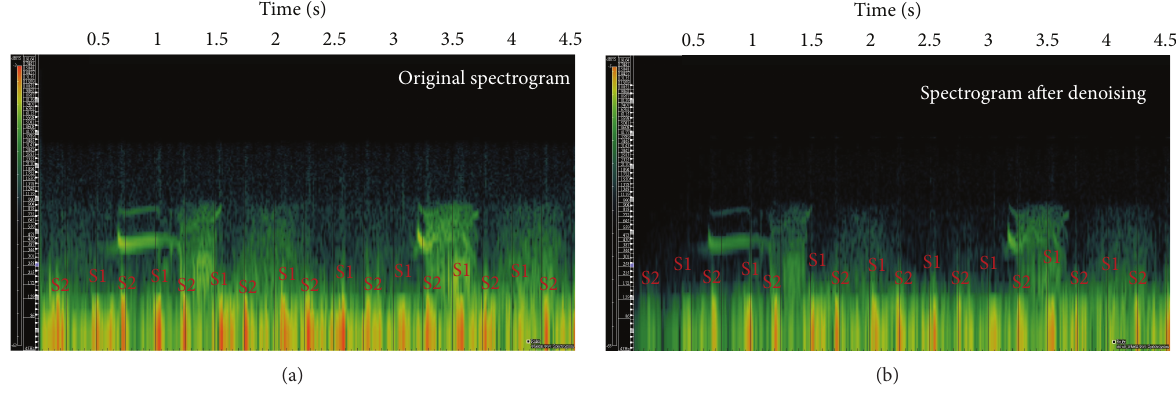
Figure 7: (a) The spectrogram of wheezes with audible heart sounds. (b) Spectrogram after processing.